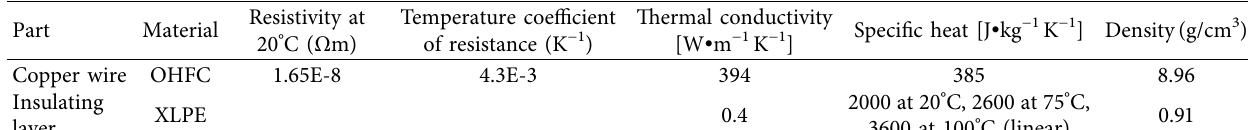
c t and σ . (a) λ vs. σ . (b) t vs. σ